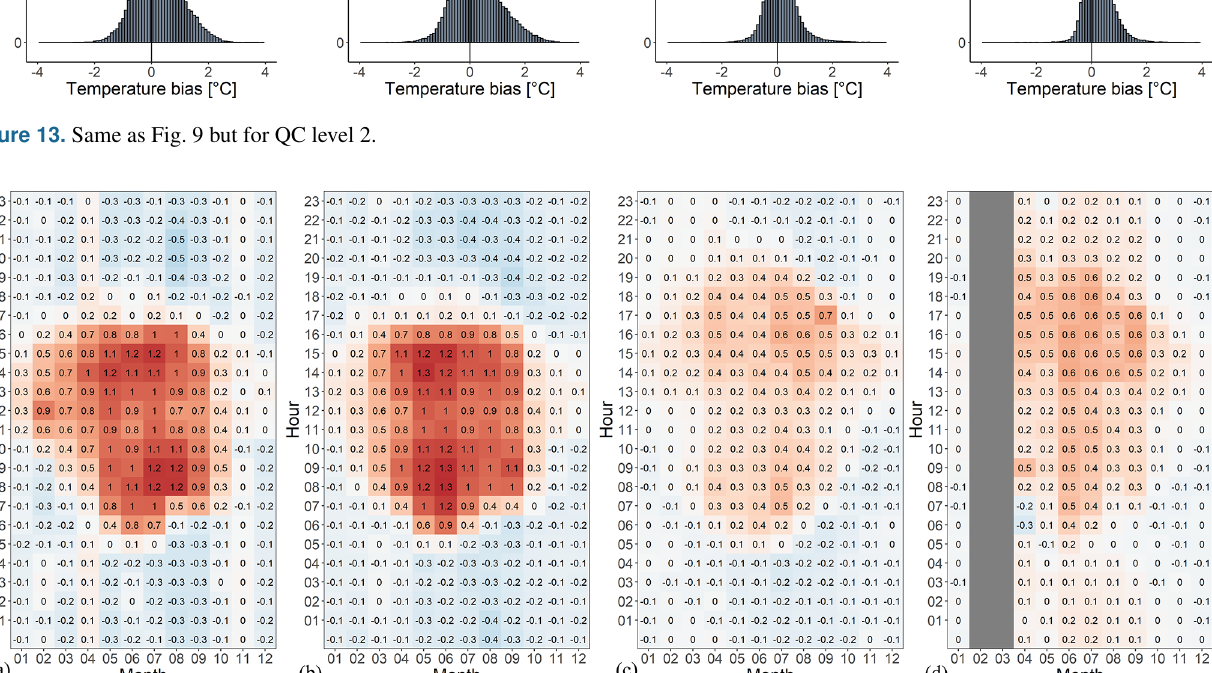
3 corrected temperature is obtained for each LC-R